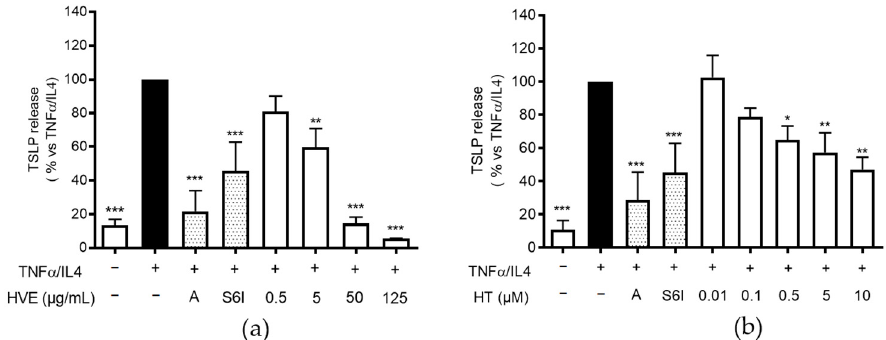
Figure 2. The inhibitory effect of HVE ( a ) and HT ( b ) treatment (24 h) on the release of TSLP using differentiated HaCaT cells challenged by TNF- α (10 ng/mL)/IL-4 (100 ng/mL), measured by the ELISA assay. The highest concentration of HT (10 µ M) corresponds to 4.93 µ g/mL. The data are expressed in percentages, relative to the stimulated control, which is arbitrarily assigned a value of 100%. * p < 0.05, ** p < 0.01, *** p < 0.001 versus stimulus. HVE, Hamamelis virginiana bark extract; HT, hamamelitannin; reference inhibitors: A, apigenin (20 µ M); S6I, STAT-6 inhibitor (50 nM).